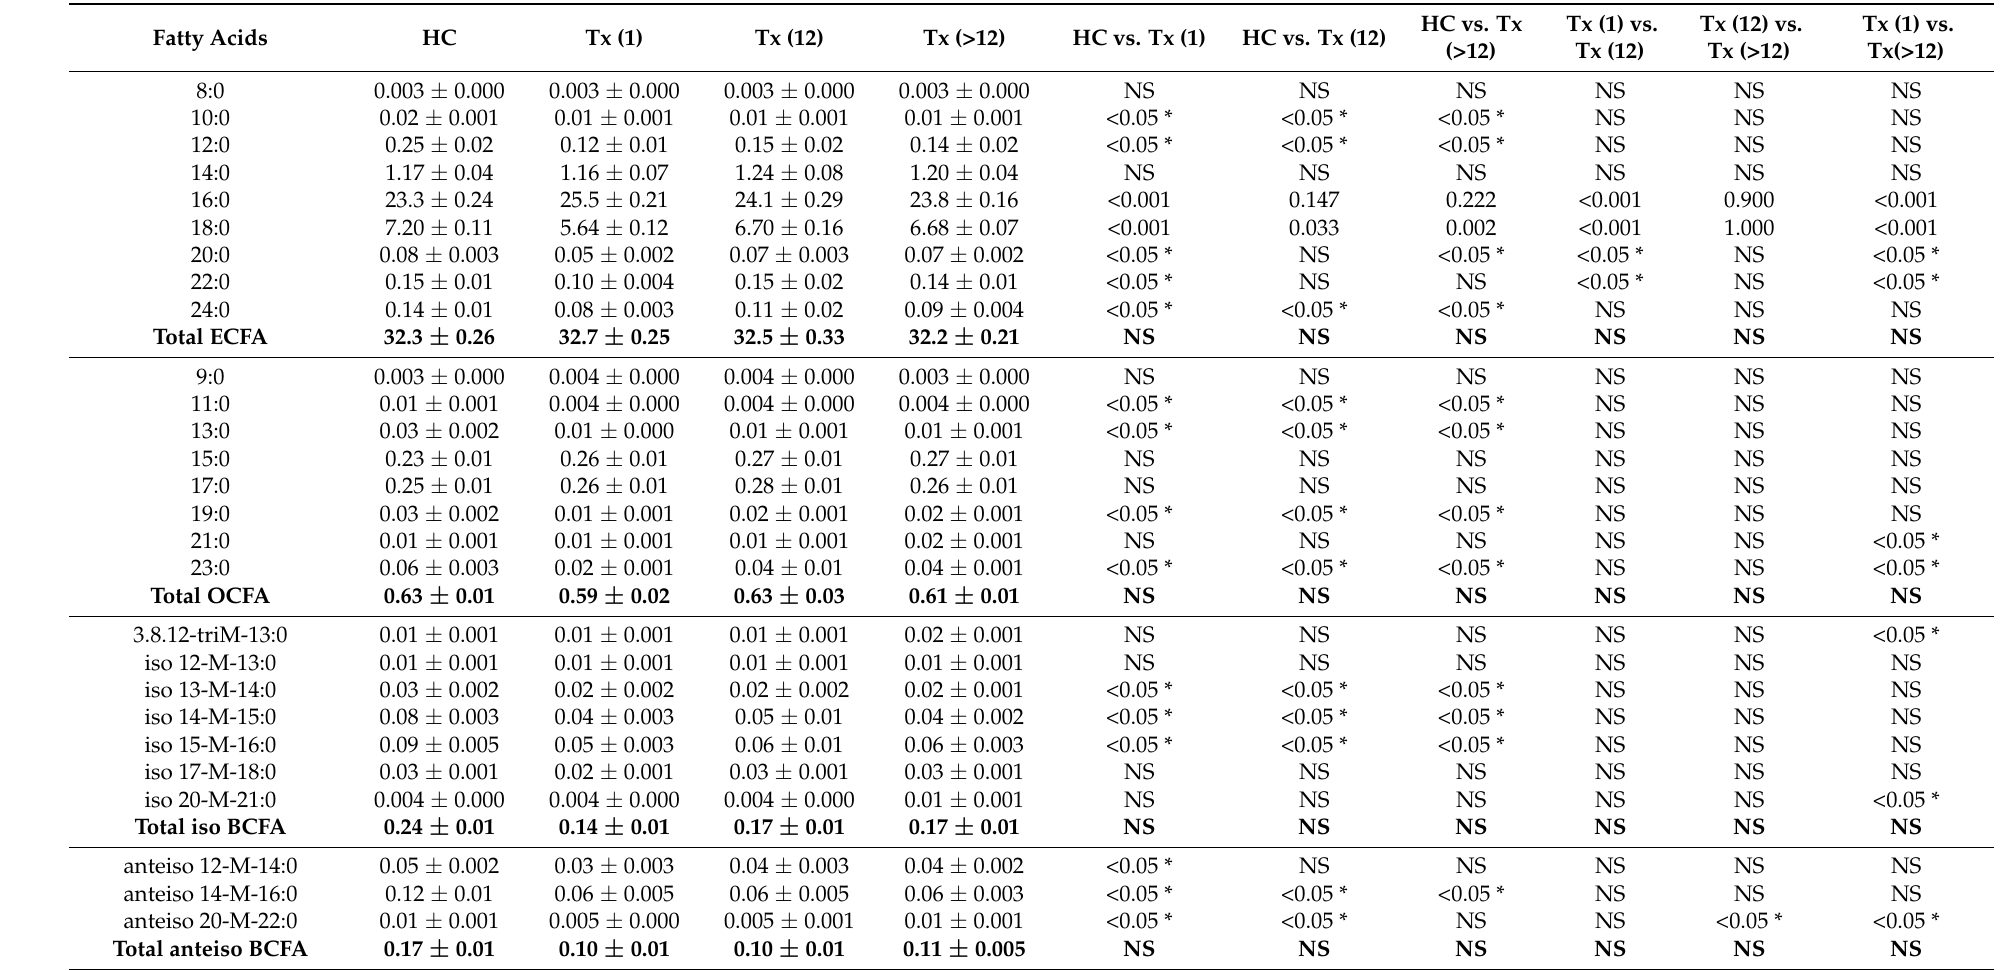
Table 3. Profile of fatty acids (%) in healthy control (HC) and kidney transplant patients (Tx) sera depending on the time after